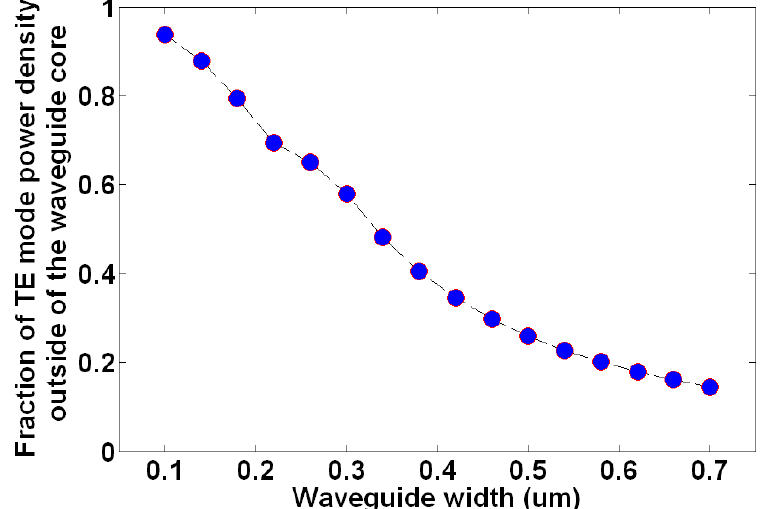
Figure 5. Silicon rectangular waveguide core width and the corresponding TE-like mode power density that extends into the cladding region. The waveguide height was kept constant at 250 nm. The cladding region refractive index was n =